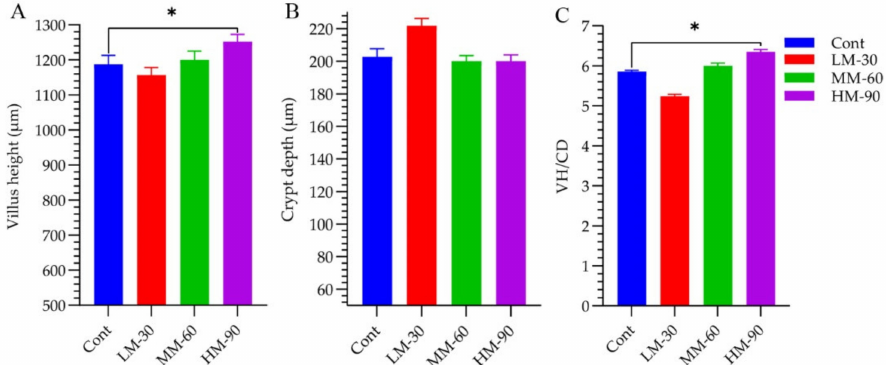
Figure 4. Effect of β -mannanase supplementation on intestinal morphology in broilers fed low energy diets. ( A ): villus height; ( B ): crypt depth; ( C ): villus height to crypt depth ratio. Cont (ME 3100 kcal/kg): without β -mannanase; LM-30 (ME − 30 kcal/kg), MM-60 (ME − 60 kcal/kg) and HM-